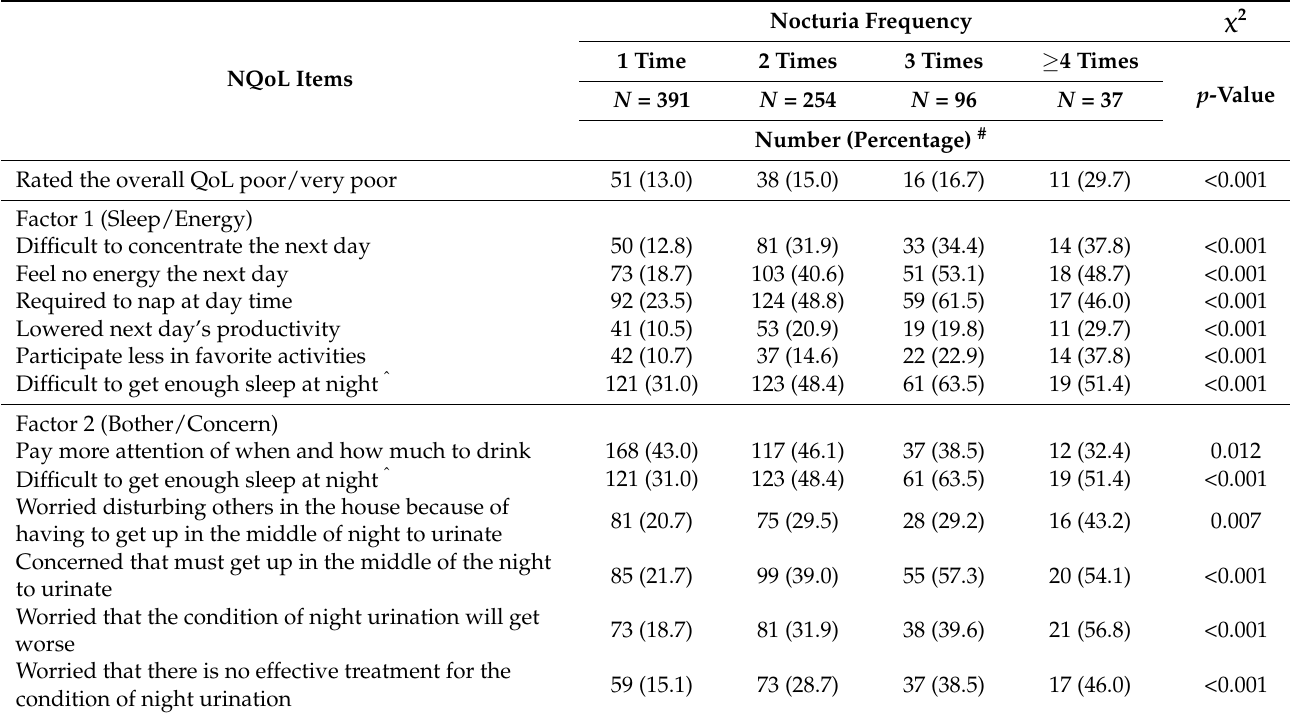
Nocturia Frequency